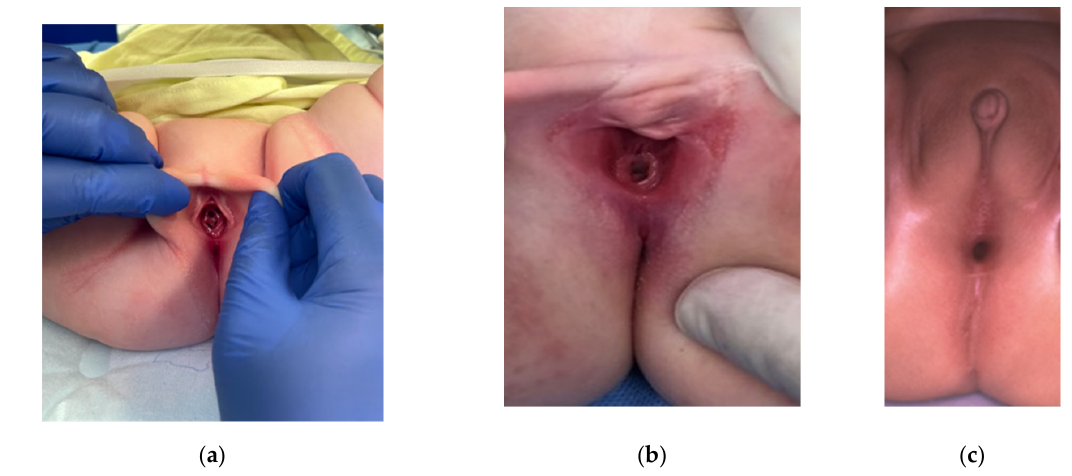
Figure 4. Female perineal exam shows: ( a ) proper technique to obtain maximal exposure ( b ), a single perineal opening at the expected urethral orifice location in a typical cloaca exam, and ( c ) a single perineal opening close to the expected anal orifice site, posterior to the urethral orifice and vestibule, consistent with a posterior cloaca.